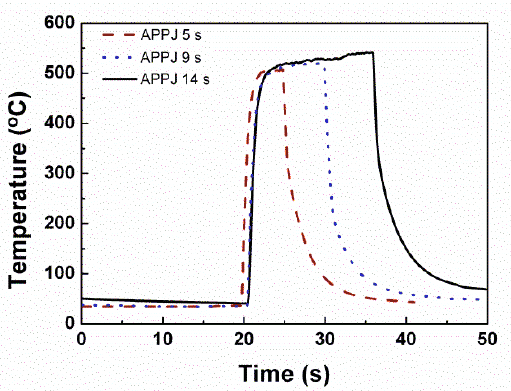
Figure 2. Substrate temperature evolutions under APPJ operation for 5, 9, and 14 s.